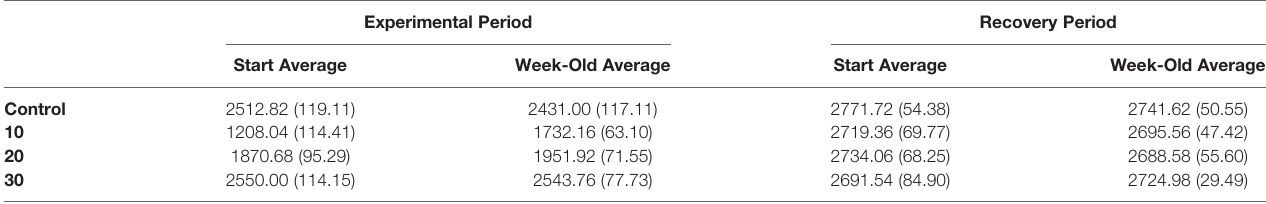
TABLE 1 | A T ( m mEq L − 1 ) values of the culture medium initially and after each week during the experimental period and recovery period (see Figure 3